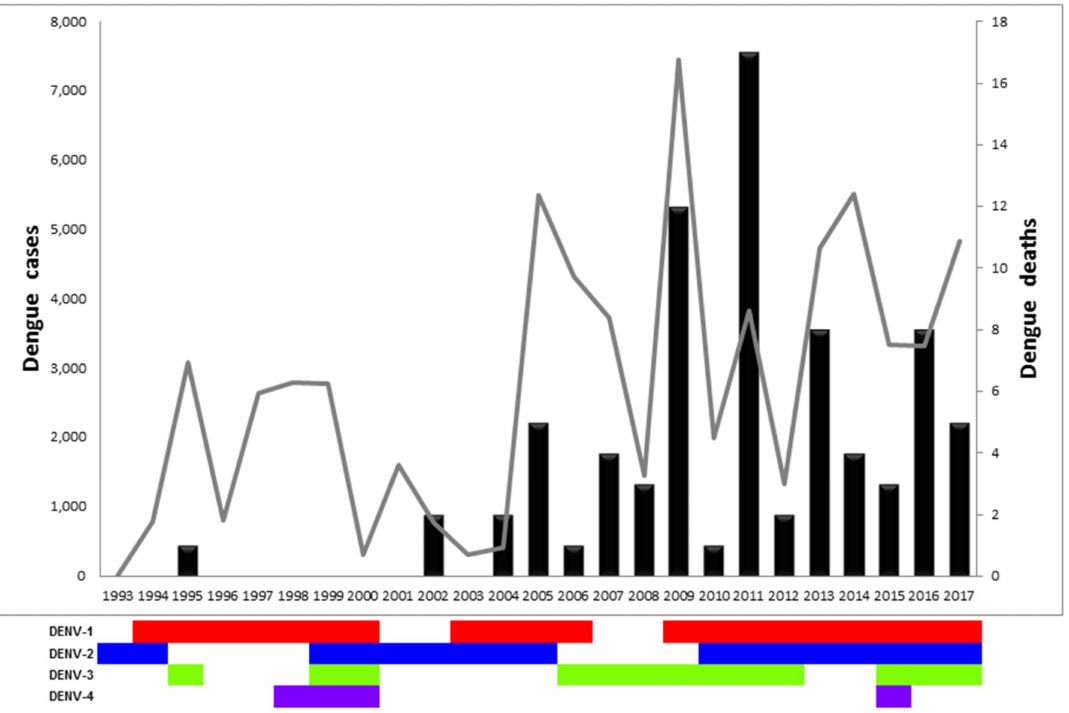
Figure 1. Dengue cases, dengue deaths, and circulating serotypes in Panama from 1993 to 2017. Graph representing the number of dengue cases (gray line, left Y axis), dengue deaths (black bars, right Y axis), and circulating serotypes per year (DENV-1 in red, DENV-2 in blue, DENV-3 in green, DENV-4 in